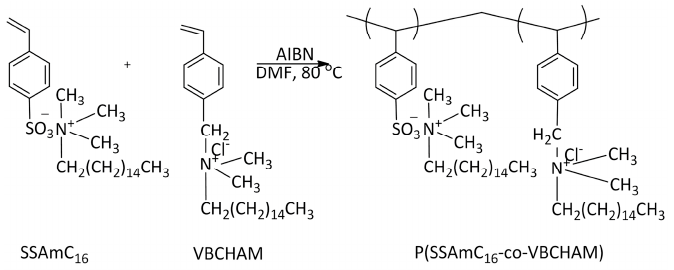
Figure 1. Chemical structures of the homopolymers PSSAmC 16 , PSSPhC 16 , PVBCHAM and the copolymers P(MMA-co-VBCHAM), P(SSNa-co-VBCHAM),